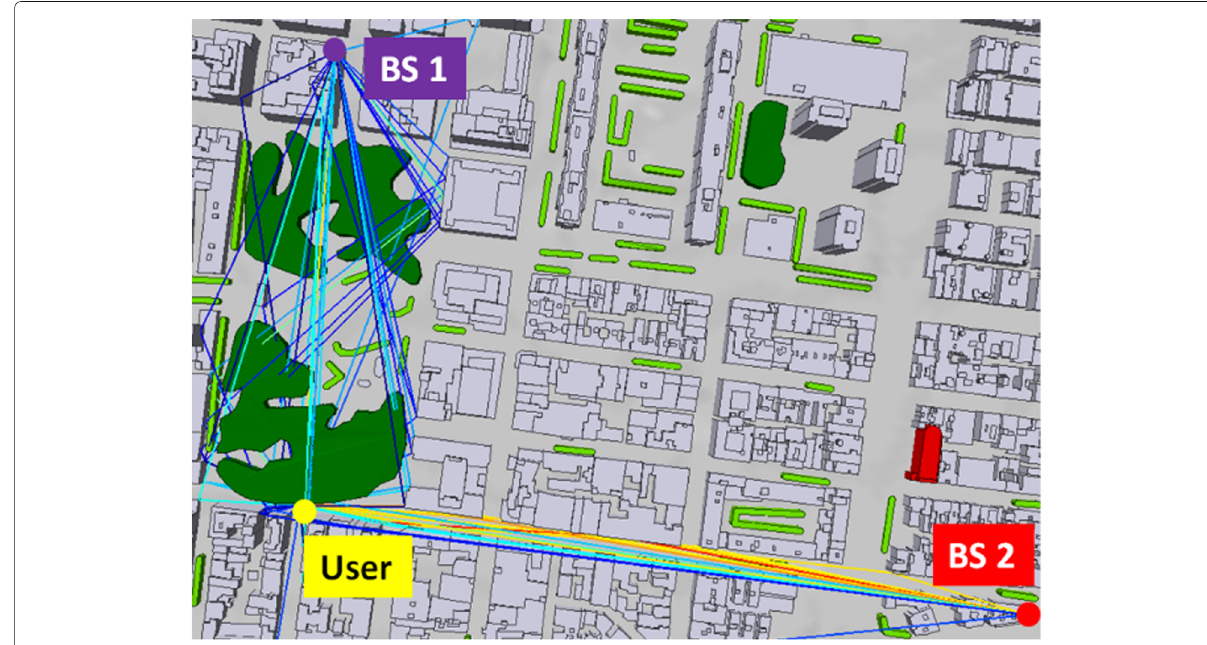
Fig. 6 Example of single user connected to multiple BSs by different propagation paths (canyoning/open